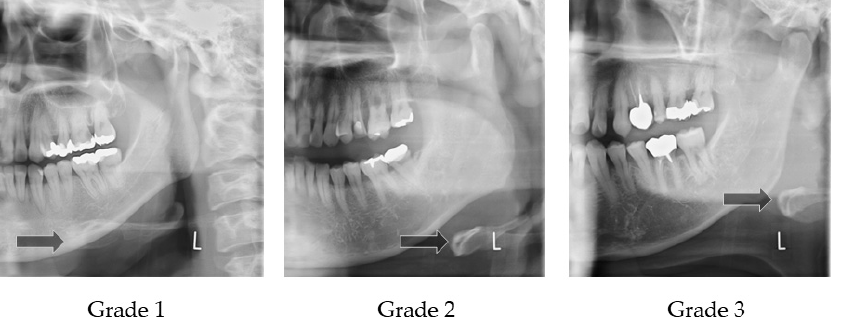
Figure 4. Sample images of horizontal hyoid bone position. Arrow shows the anterior point of the hyoid body.